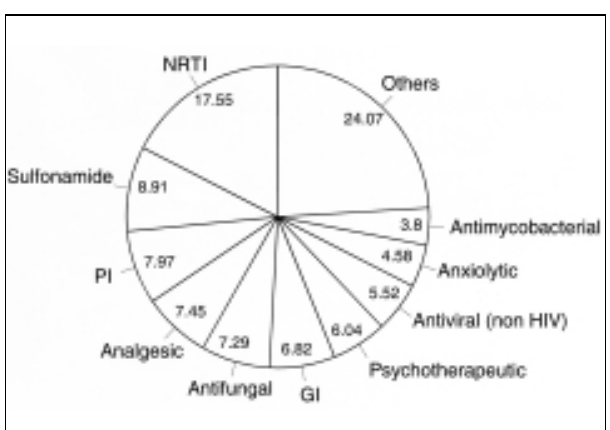
Figure 2) Drug classes taken after highly active antiretroviral therapy (phase 2). The percentage breakdown of medication classes is equal to thetotalnumberofdrugstakenperclassdividedbythetotalnumberof drugs taken in all classes. GI Gastrointestinal; PI Protease